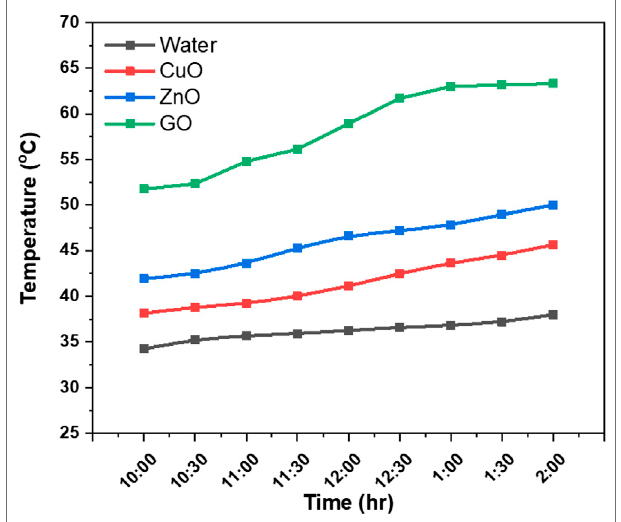
FIGURE 7 | Temperature pro fi le of all working fl uids for a speci fi c day of the summer season of June 2019.